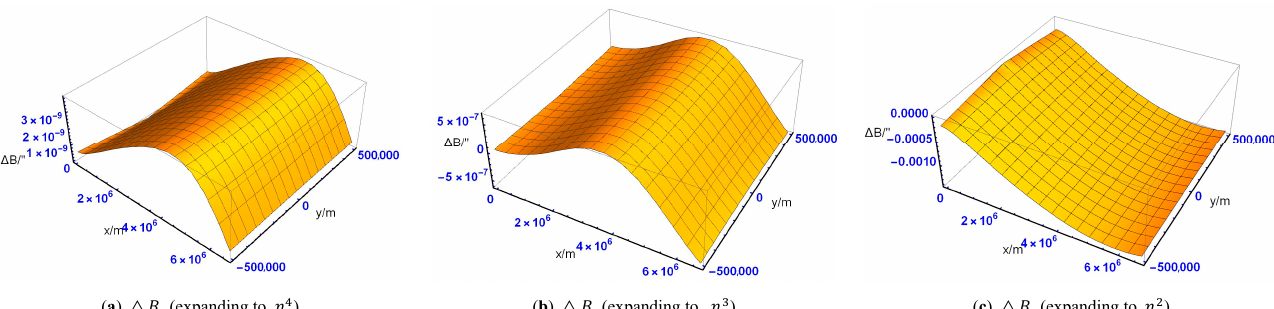
ISPRS Int. J. Geo-Inf. 2022 , 11 , x FOR PEER REVIEW Figure 9. The distribution of the longitude truncation difference △ 𝑙 when expanding to 𝑒 (cid:2876) , 𝑒 (cid:2874) , and 𝑒 (cid:2872) .